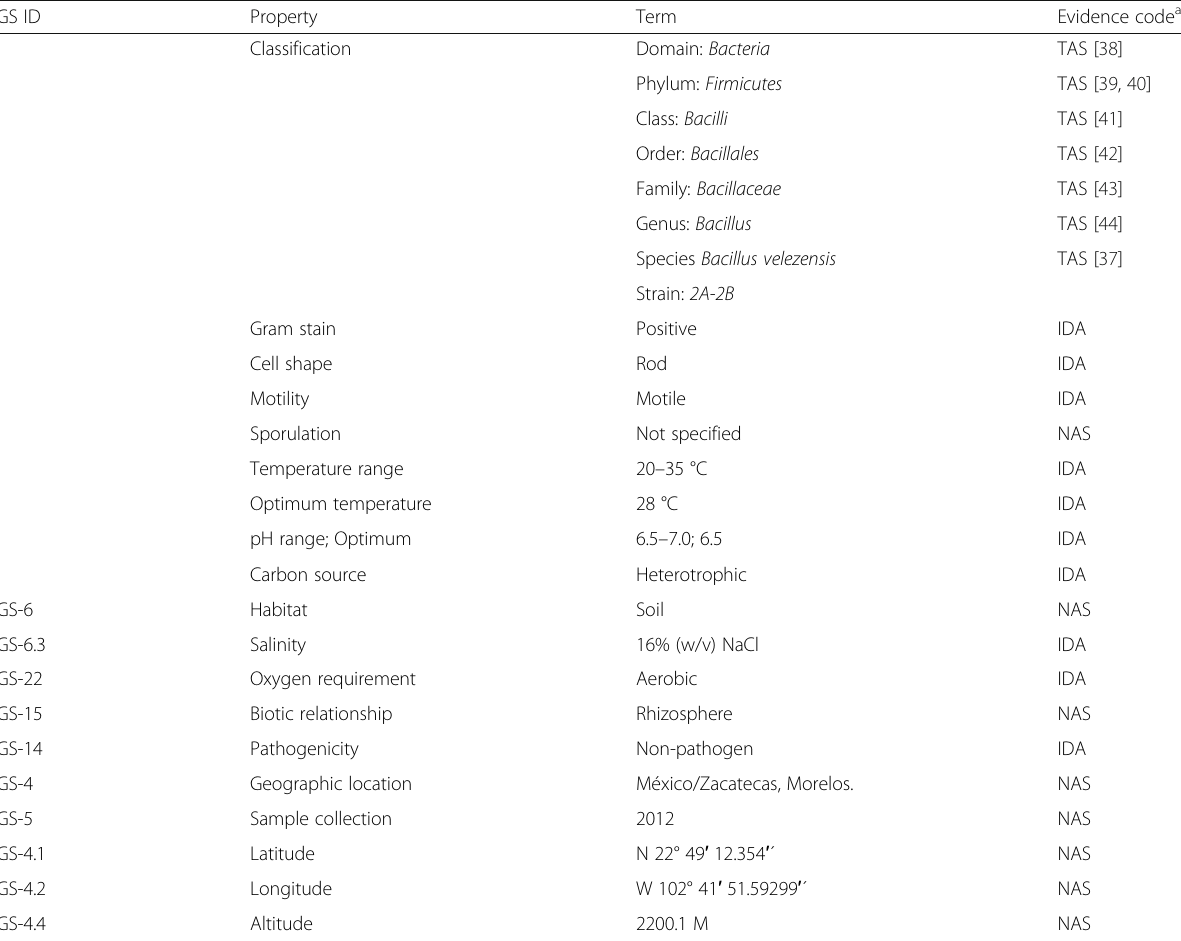
Fig. 1 Cellular morphology of B. velezensis 2A-2B. Gram-positive bacteria under phase contrast with a Leica DM2500 compound microscope with Nomarski differential interference contrast